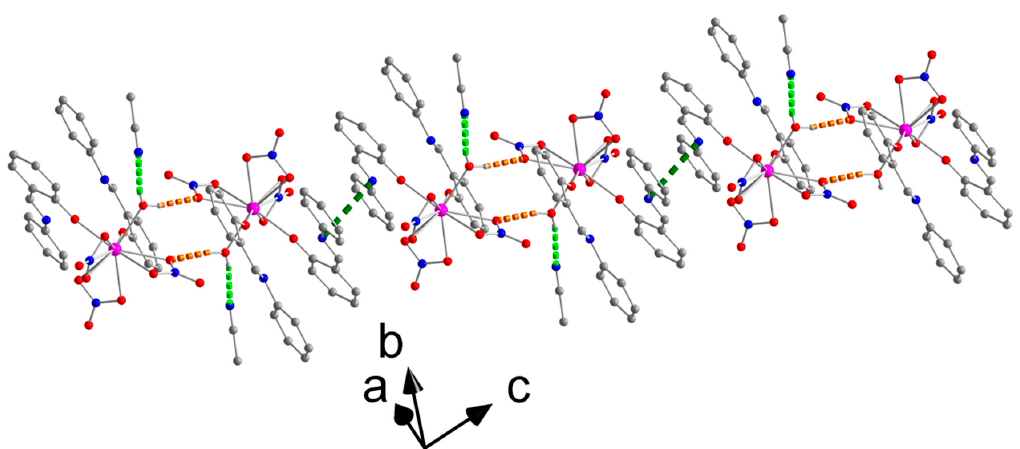
Figure 7. A portion of a chain of H-bonded dimers formed through π - π stacking interactions in the crystal structure of 7 · MeCN_Dy. The chain is parallel to the [-101] crystallographic direction. The π - π interactions are indicated by the dashed, dark green lines. The dashed, light green and orange lines represent the O1W-H B (O1W) ··· N6 and O1W-H A (O1W) ··· O6’ ( − x + 2, − y , − z − 1) intermolecular H bonds, respectively.